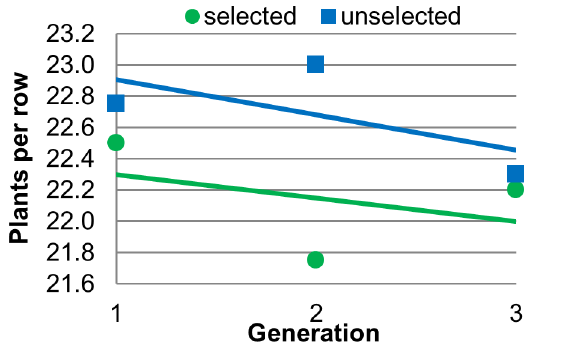
Fig 5. Effect of selection on germination rate. Data points are mean number of plants per row values versus generation, shown with the linear regression trend lines. The equations of the lines for the selected and unselected populations are y = -0.15x + 22.45 (R 2 = 0.1579) and y = -0.225x + 23.133 (R 2 = 0.4023) respectively.